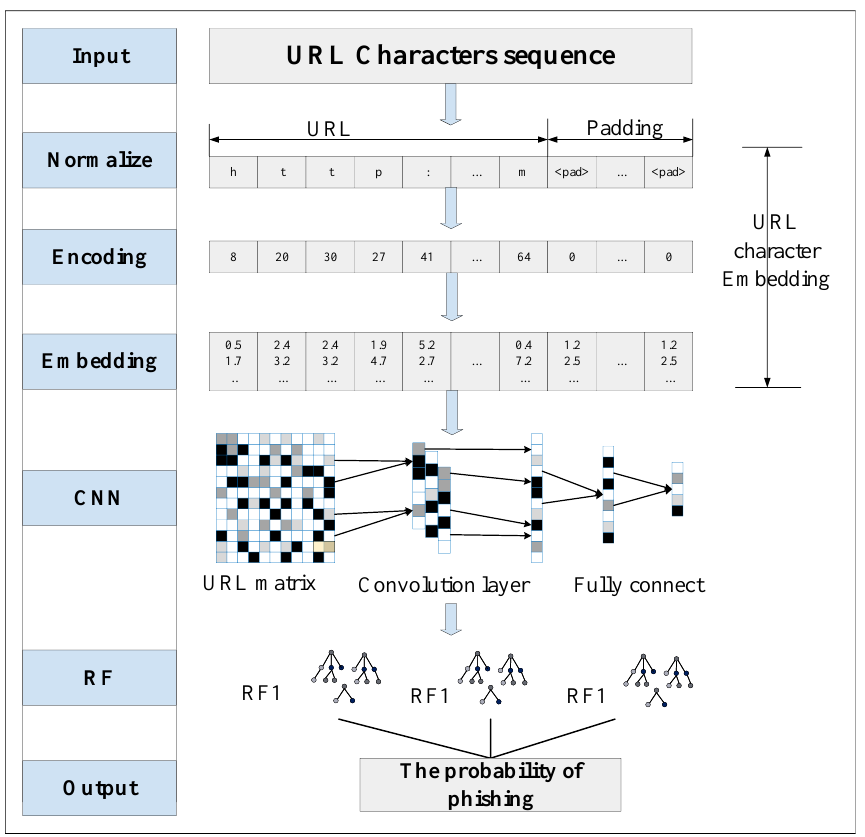
Figure 3. Framework of the proposed